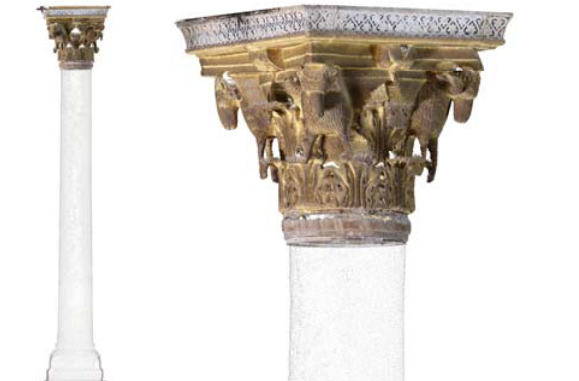
Figure 2: example of multiscale acquisition. The lower part of the column was acquired with 24 mm and the resulting point cloud has a less than 1 cm